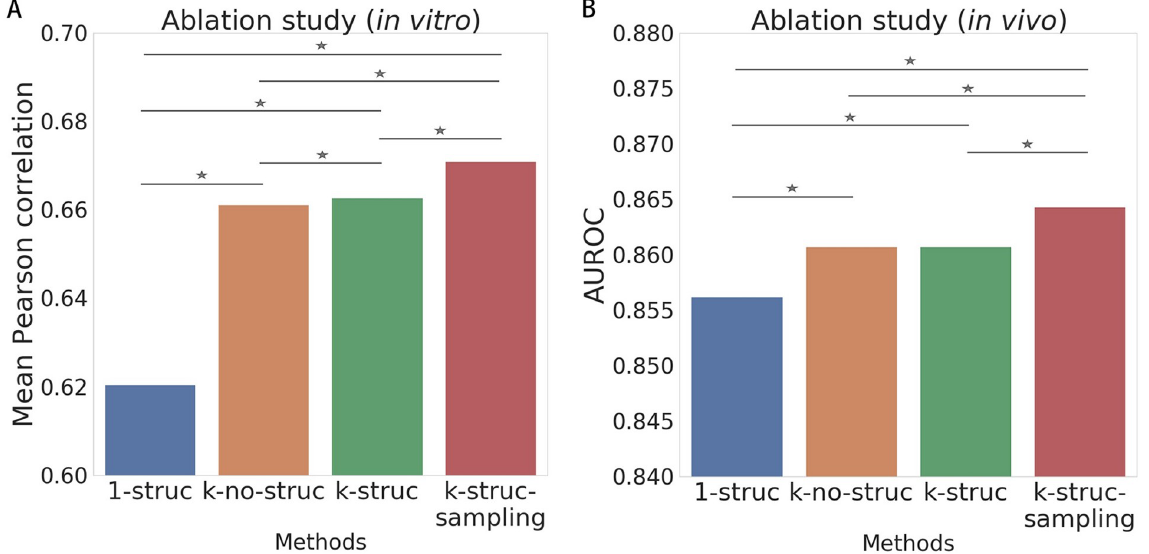
Fig 4. Ablation analysis of various designs in ThermoNet using (A) in vitro and (B) in vivo datasets. Several variants of ThermoNet were built and evaluated, including 1-struc (blue): training only one CNN with 1-mer representations and averaged secondary structure information. k-no-struc (brown): training only one network with various k -mer representations but without any structure information. k-struc (green): training only one CNN with various k -mer representations as well as averaged structure information. k-struc-sampling (red): training various networks for individual secondary structures. All variants received the sequence embedding settings as input. ? : one-sided Wilcoxon signed rank test p -value < 0.05.